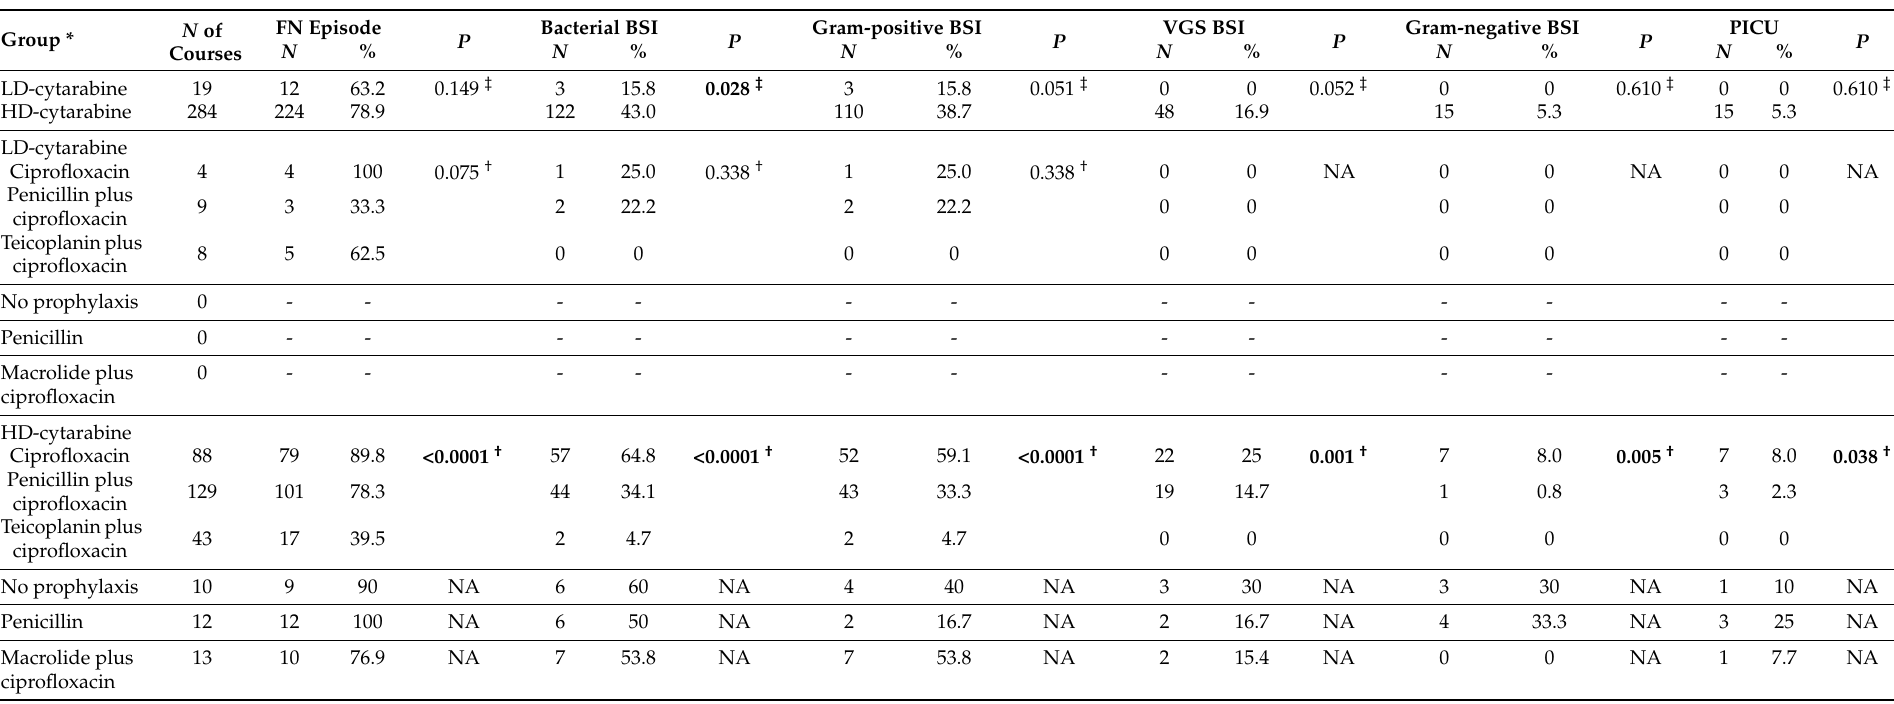
Table 4. The incidence of febrile neutropenic episodes, bacterial bloodstream infections, and bacterial bloodstream infection-related pediatric intensive care